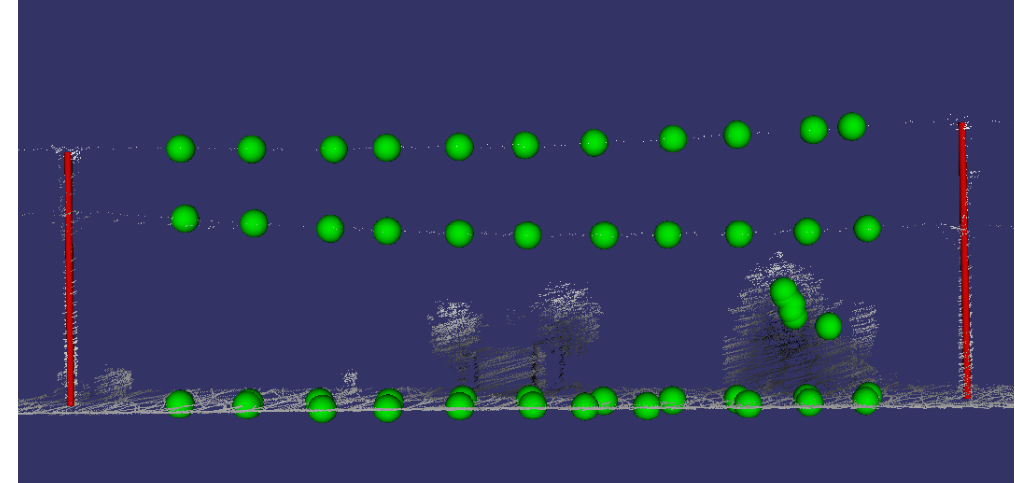
Figure 2. An example of the multiple centre of masses found for each window. Note the bush in the lower right is partially within the conductor search region and thus has centre of masses associated with it.